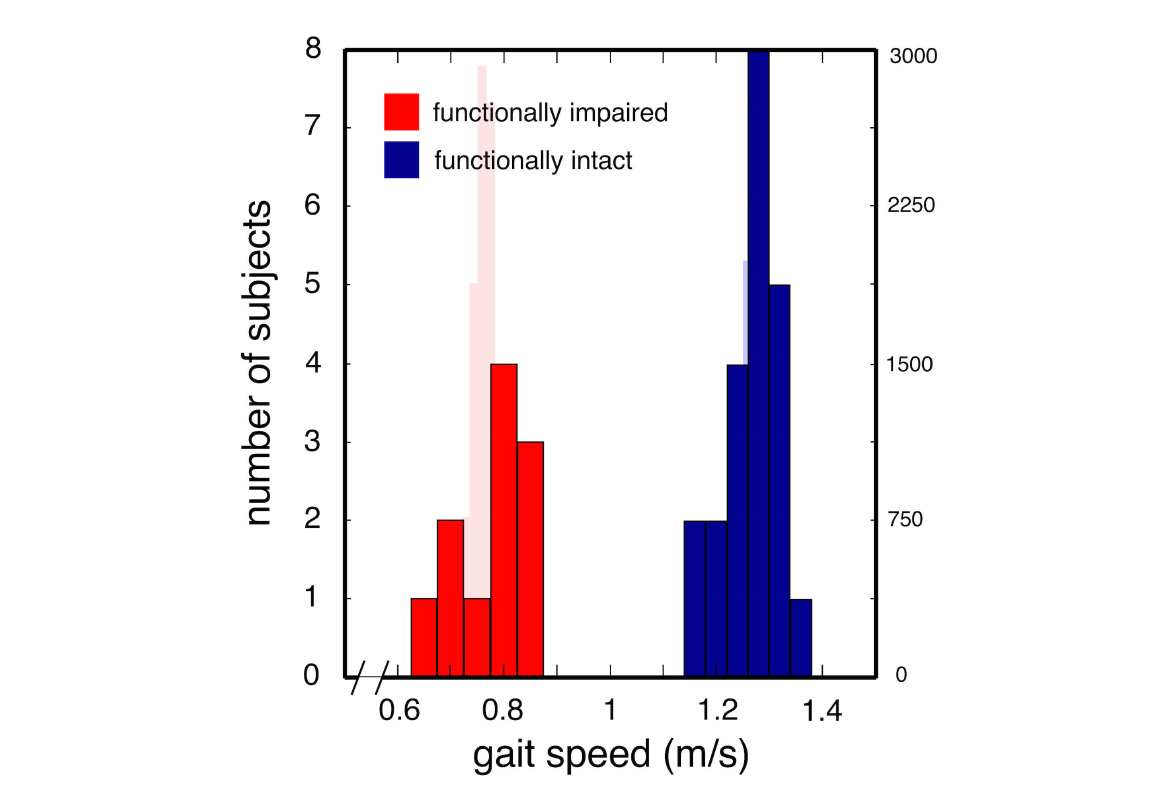
Figure 4. Mean daily gait speed histogram depicting significant differences between functionally intact (blue) and functionally impaired (red) participants. Bootstrap estimates of mean gait speed are provided behind data histograms (light red for functionally impaired; estimate for functionally intact group is completely behind data